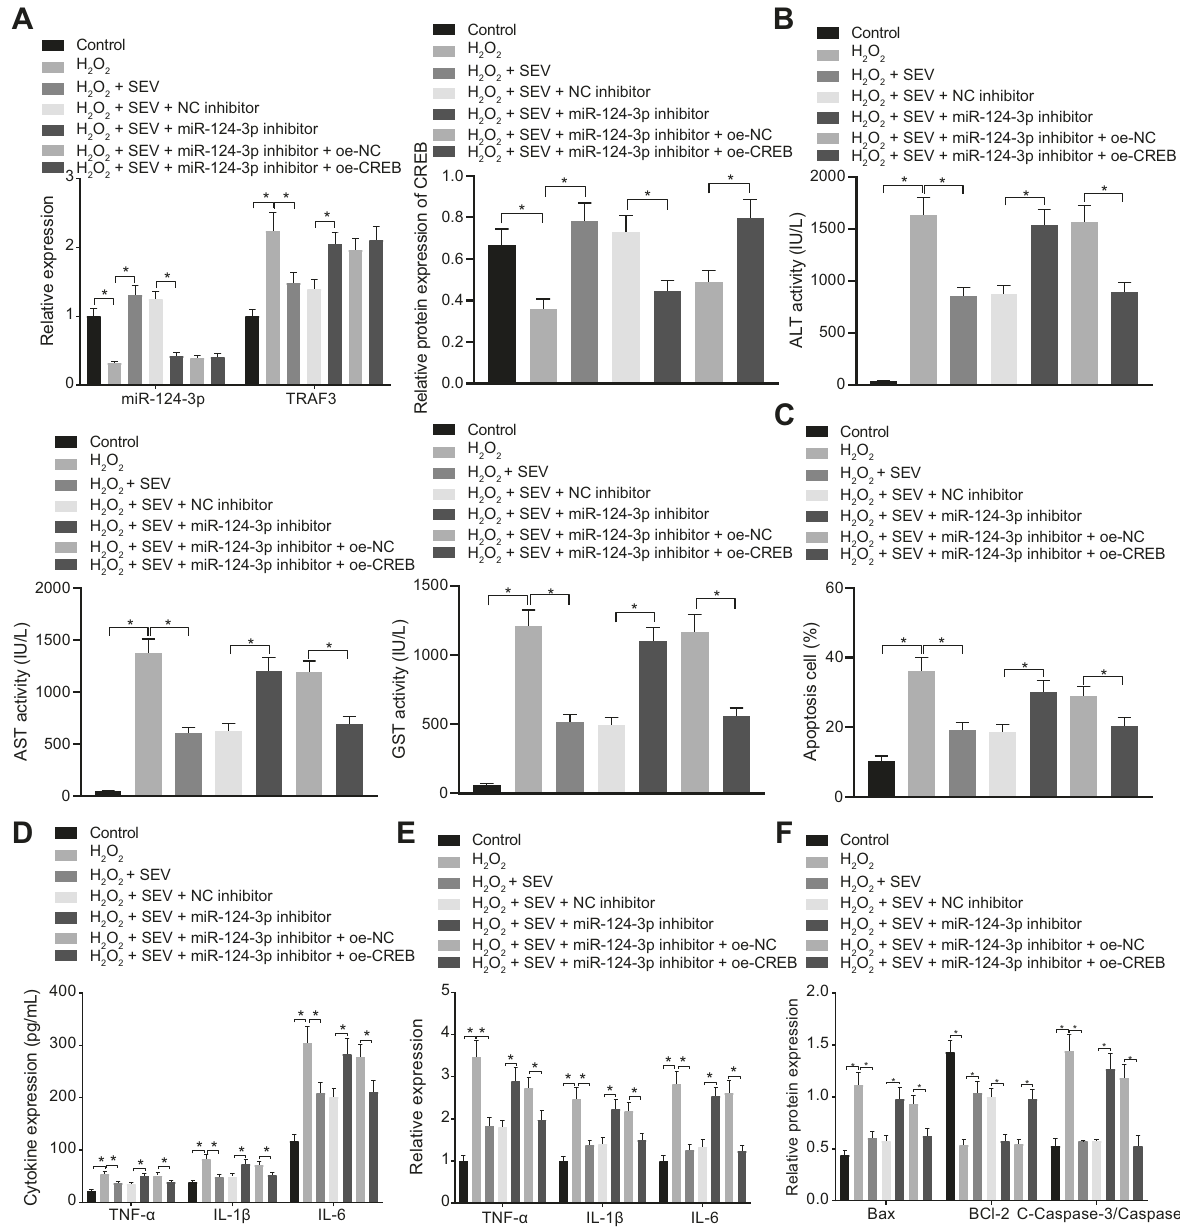
Fig. 5 SEV inhibits H 2 O 2 -induced hepatocyte apoptosis and release of in fl ammatory factors through the miR-124-3p/TRAF3/CREB axis. A The expression of miR-124-3p and TRAF3 determined by RT-qPCR and CREB protein expression measured by Western blot analysis in hepatocytes in the presence of SEV, SEV + miR-124-3p inhibitor, or SEV + miR-124-3p inhibitor + oe-CREB. B Serum levels of GST, ALT, AST, and GST in hepatocyte supernatant in the presence of SEV, SEV + miR-124-3p inhibitor, or SEV + miR-124-3p inhibitor + oe-CREB detected by ELISA. C Hepatocyte apoptosis in the presence of SEV, SEV + miR-124-3p inhibitor, or SEV + miR-124-3p inhibitor + oe-CREB detected by fl ow cytometry. D The expression of TNF- α , IL-1 β , and IL-6 in hepatocyte supernatant in the presence of SEV, SEV + miR-124-3p inhibitor, or SEV + miR-124-3p inhibitor + oe-CREB detected by ELISA. E The expression of TNF- α , IL-1 β , and IL-6 in hepatocytes in the presence of SEV, SEV + miR-124-3p inhibitor, or SEV + miR-124-3p inhibitor + oe-CREB detected by RT-qPCR. F The protein expression of Bax, Bcl-2, and cleaved- caspase-3 in hepatocytes in the presence of SEV, SEV + miR-124-3p inhibitor or SEV + miR-124-3p inhibitor + oe-CREB detected by Western blot analysis. * p < 0.05. The cell experiment was repeated three times. opposite fi ndings in I/R mice, which was neutralized by SEV + sh- CREB (Fig. 6G and Supplementary Fig. 1J). DISCUSSION I/R injury is one of the leading causes of liver damage occurring during hepatic resection and transplantation, signi fi cantly con- tributing to liver dysfunction and post-transplantation failure [18]. Cell Death Discovery (2022)